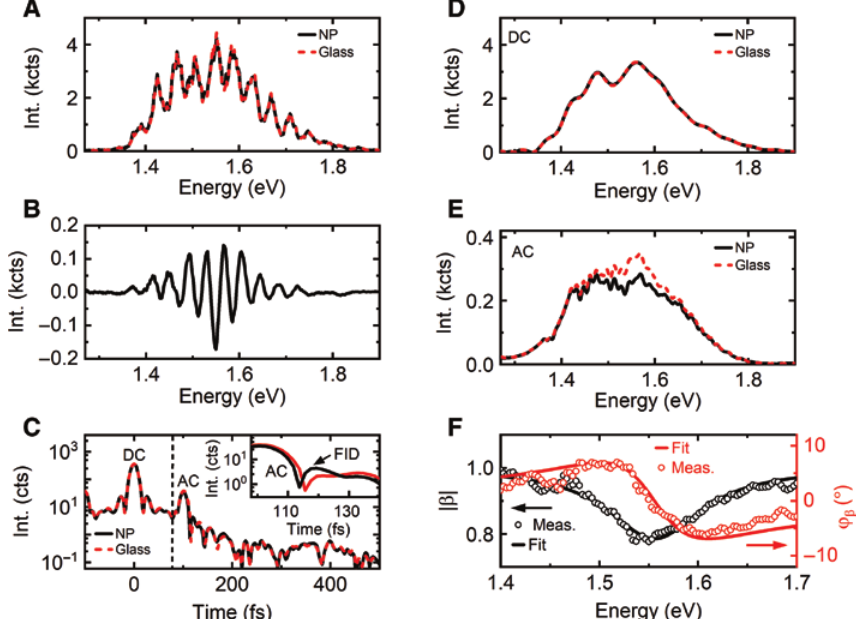
Figure 2: Analysis of PNSI spectra from a single nanorod. (A) Spectral interferogram recorded from scatterer S3 in Figure 1B, with the tip positioned near the apex of a nanorod (black) or on the glass substrate (red). (B) Difference between the nanorod spectrum and the reference spectrum. (C) Fourier transforms (FTs) of the interferograms in panel (A), showing the amplitude of s ( t ) at 0 fs, and the amplitude of the positively delayed AC component s ( t ), at ~ 100 fs time delay. The + 0 free induction decay (FID) of the nanorod, leading to a single-sided broadening of s ( t ), is highlighted in the inset. (D, E) Temporal separation + of s ( t ) and s ( t ) and their Fourier back-transform into the frequency domain gives (D) | S ( ω ) | and (E) | S ( ω )| on glass (dashed red) and near + + 0 0 the nanorod apex (solid black). The ratio between S ( ω ) on the nanoparticle and on glass provides the absorption by the longitudinal LSP + resonance of the particle. (F) Nanorod scattering spectra retrieved (see Section 5) from the AC and DC components in (D, E) and fitted to a Lorentzian line shape